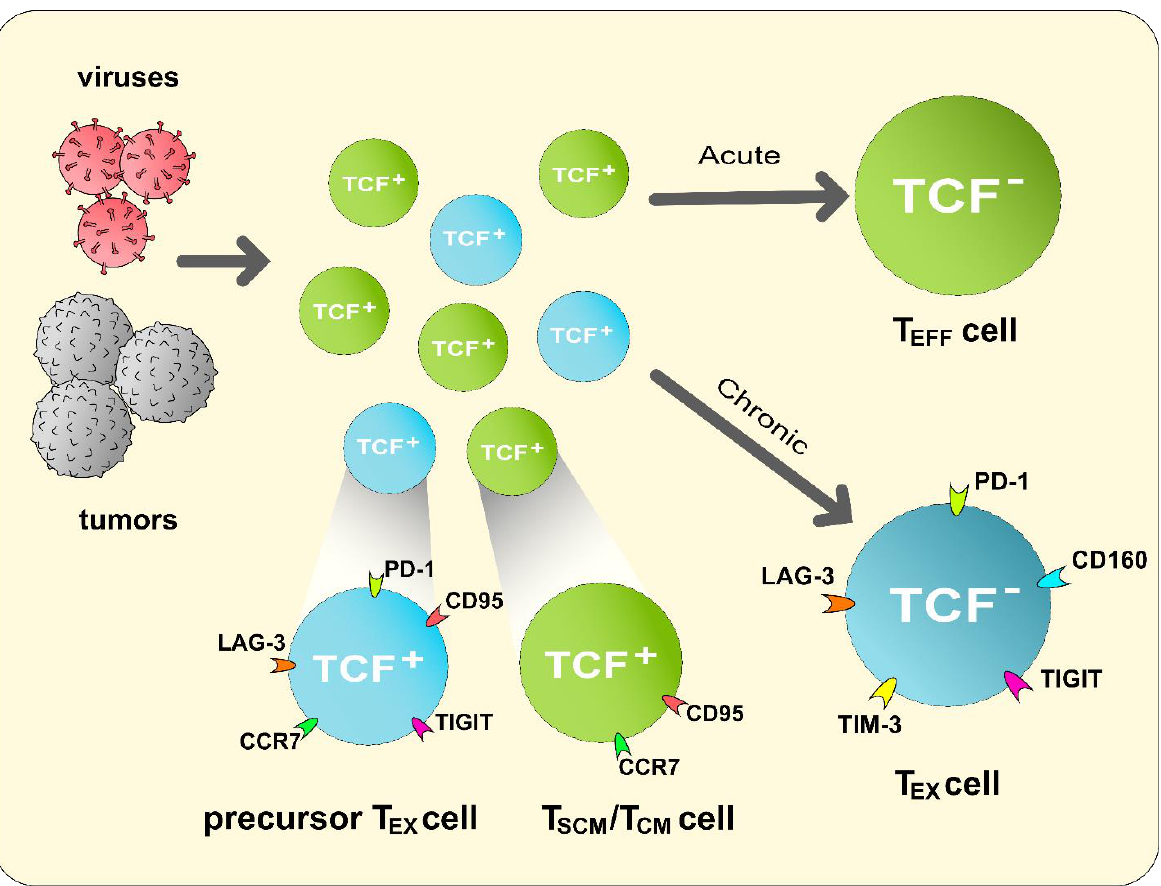
Figure 2. An alternative theory of CD8 + T EX cell generation where a cell pool consisting of both precursor exhausted and non-exhausted CD8 + T cells is generated and expanded in response to a particular pathogenic stimulation. Depending on the acute or chronic nature of the pathogenic antigen stimulation, a particular subgroup is selected to best clear the pathogen while minimizing host cell injury.